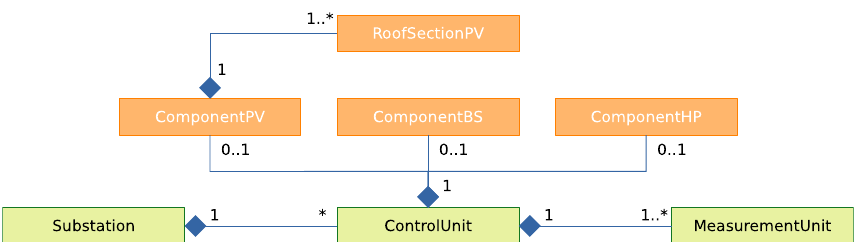
Fig. 6 The UML class diagram of the implementation with the cardinalities given. Orange boxes depict simulated components, green boxes depict units representing real